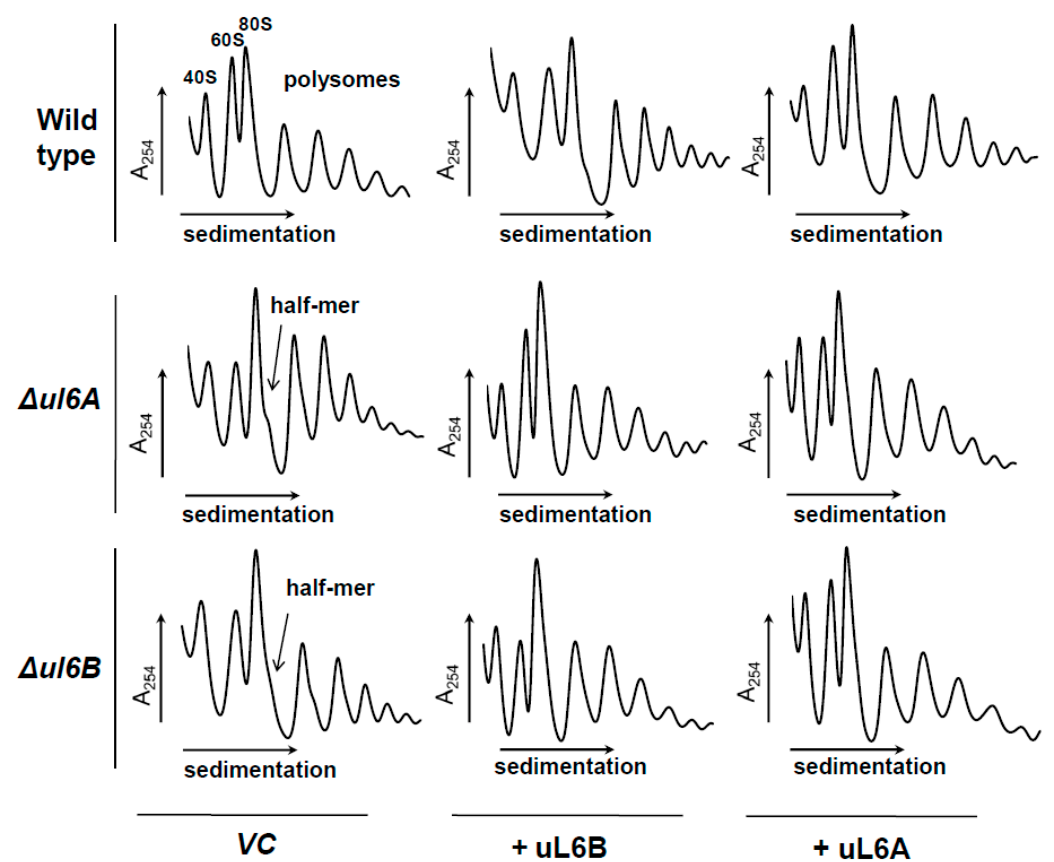
Figure 5. Polysome profile analysis of wild type and single uL6A or uL6B deletion mutants with overexpression of uL6A or uL6B. The yeast strains were grown on SD–Ura medium. The sedimentation vector of the ribosomal fractions is indicated by a horizontal arrow, and optical density analysis at 254 nm is shown on the Y -axis; the position of individual ribosomal subunits and half-mers are indicated.